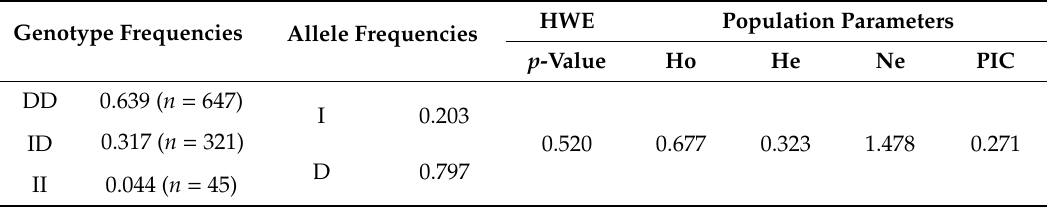
Table 2. PCR primers used for detecting indels in the goat HIAT1 gene.